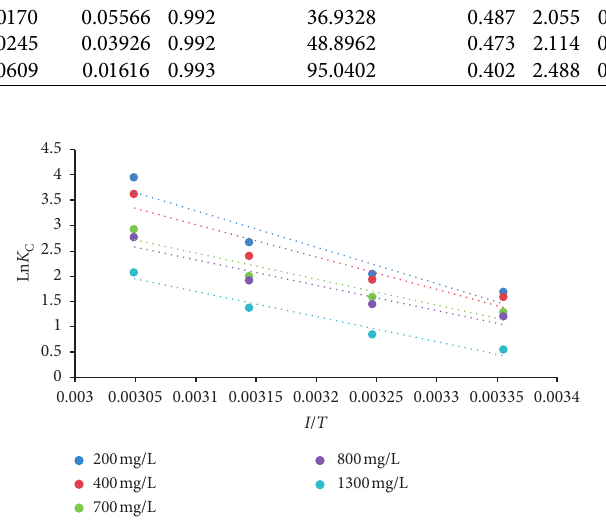
Figure 11: Thermodynamic parameters for MnO Table 6: Thermodynamic constants for MnO